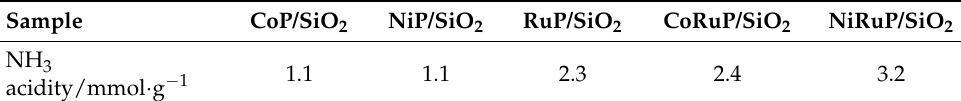
Table 2. Acid sites analysis by NH 3 -TPD.